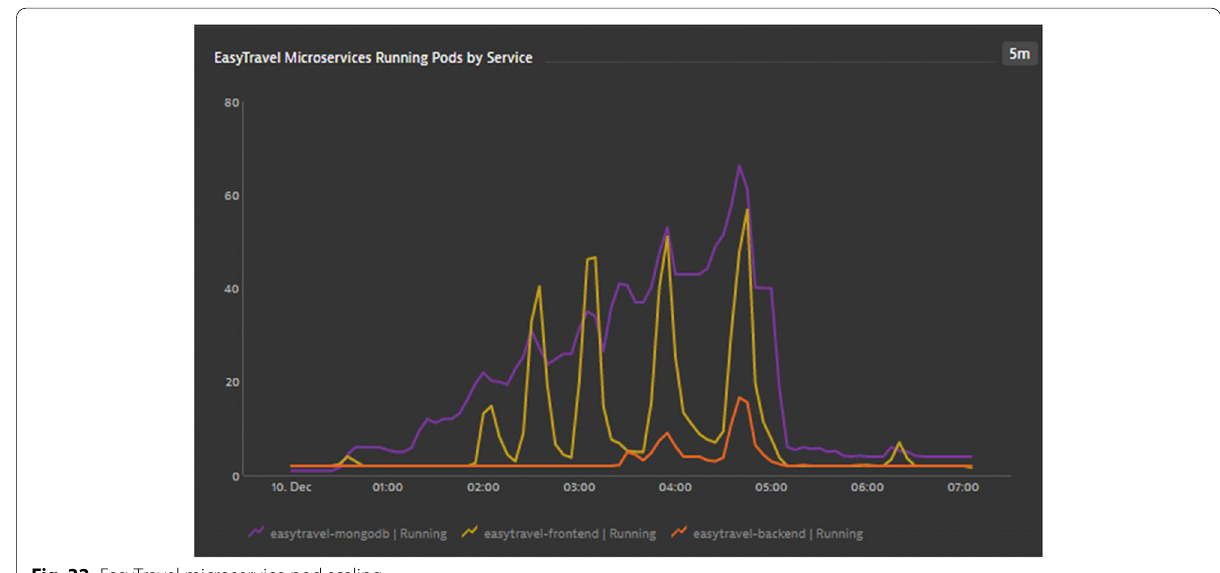
Fig. 32 EasyTravel microservice pod